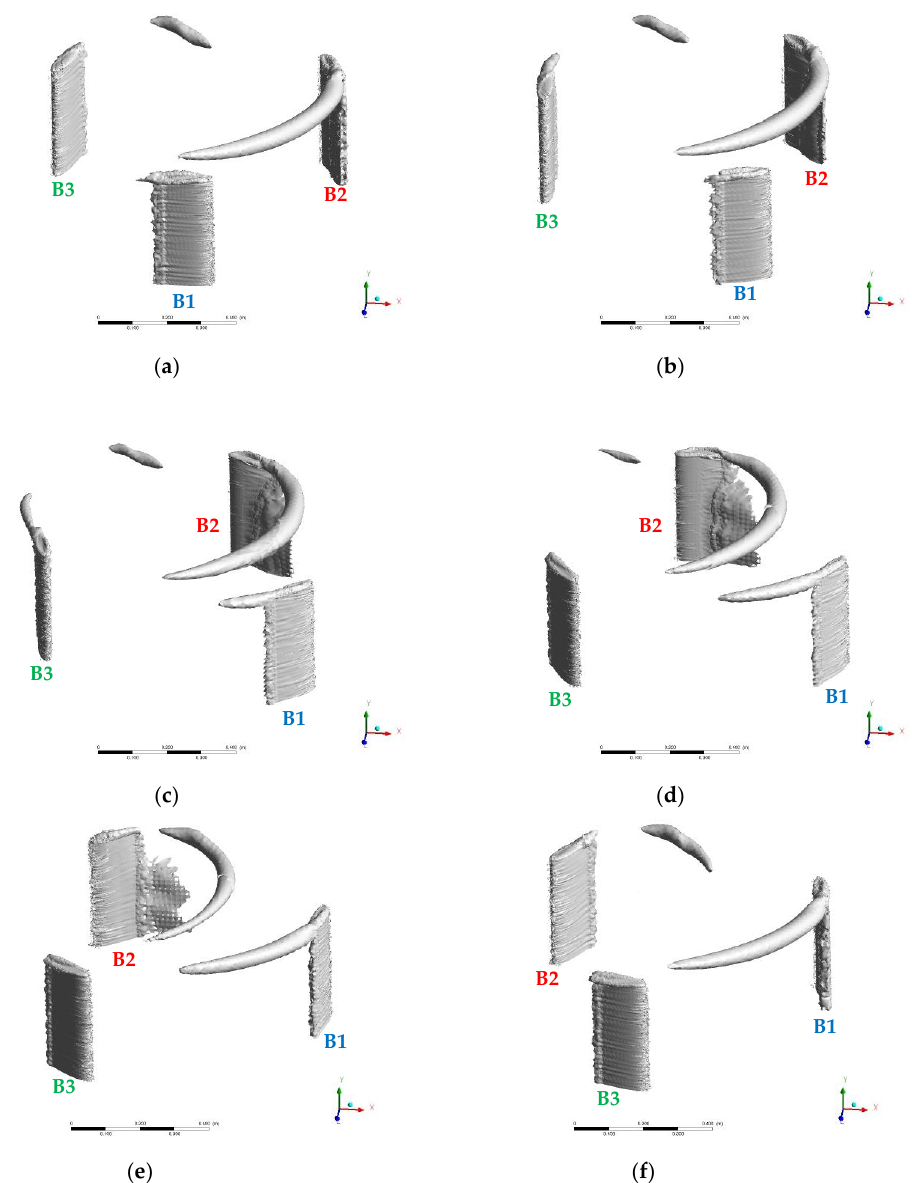
Figure 8. 3D visualization of the evolution of the vorticity iso-surface of 60 Hz for Ω = 70 rpm. Azimuth angle change at each view from ( a – f ) corresponds to 20 o , approximately.